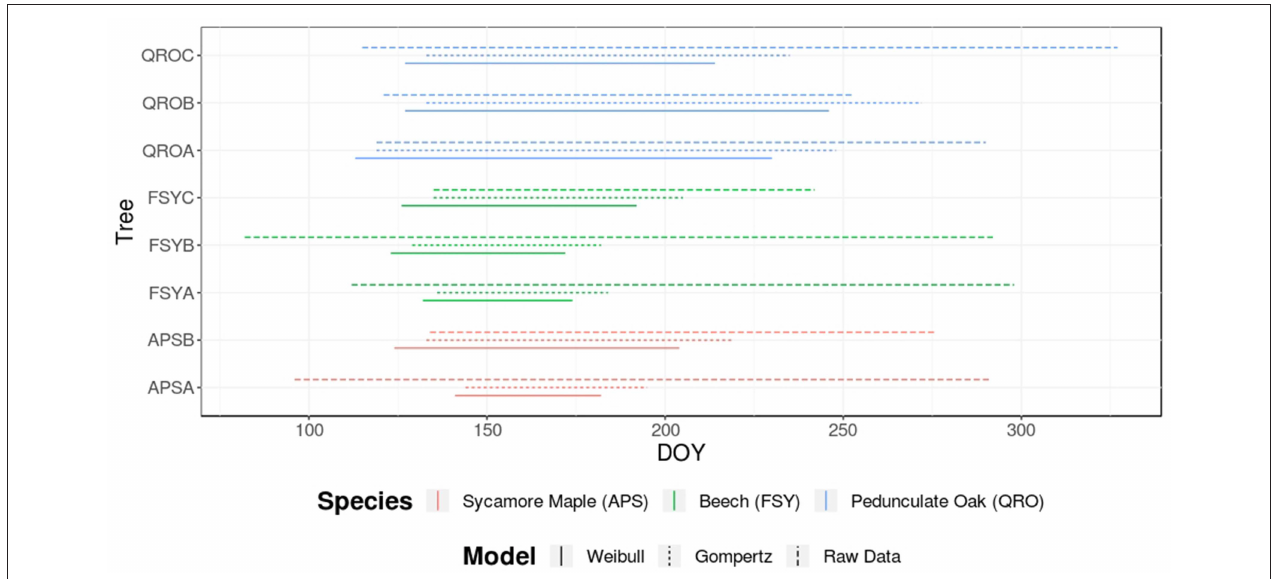
FIGURE 3 | Derived phenology estimates from dendrometer data for three main broadleaved tree species of central Europe and treated in the presented case study. The lines represent the growth period of the monitored trees according to the estimated dates by the fitted models (and also by the raw-unfitted dendrometer measurements for comparison). The color of the lines indicate the species and the line type the model fitting used to derive phenological phases.